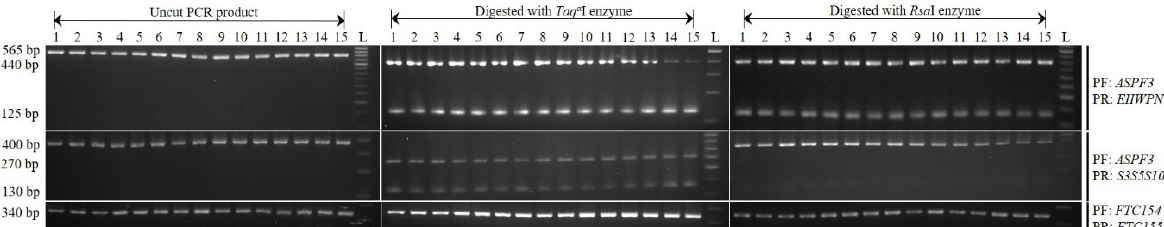
Figure 6: Agarose gel images displaying the PCR products amplified with three markers and the digested PCR products with the restriction enzymes Taq α I and Rsa I. 1-15 represent apple trees